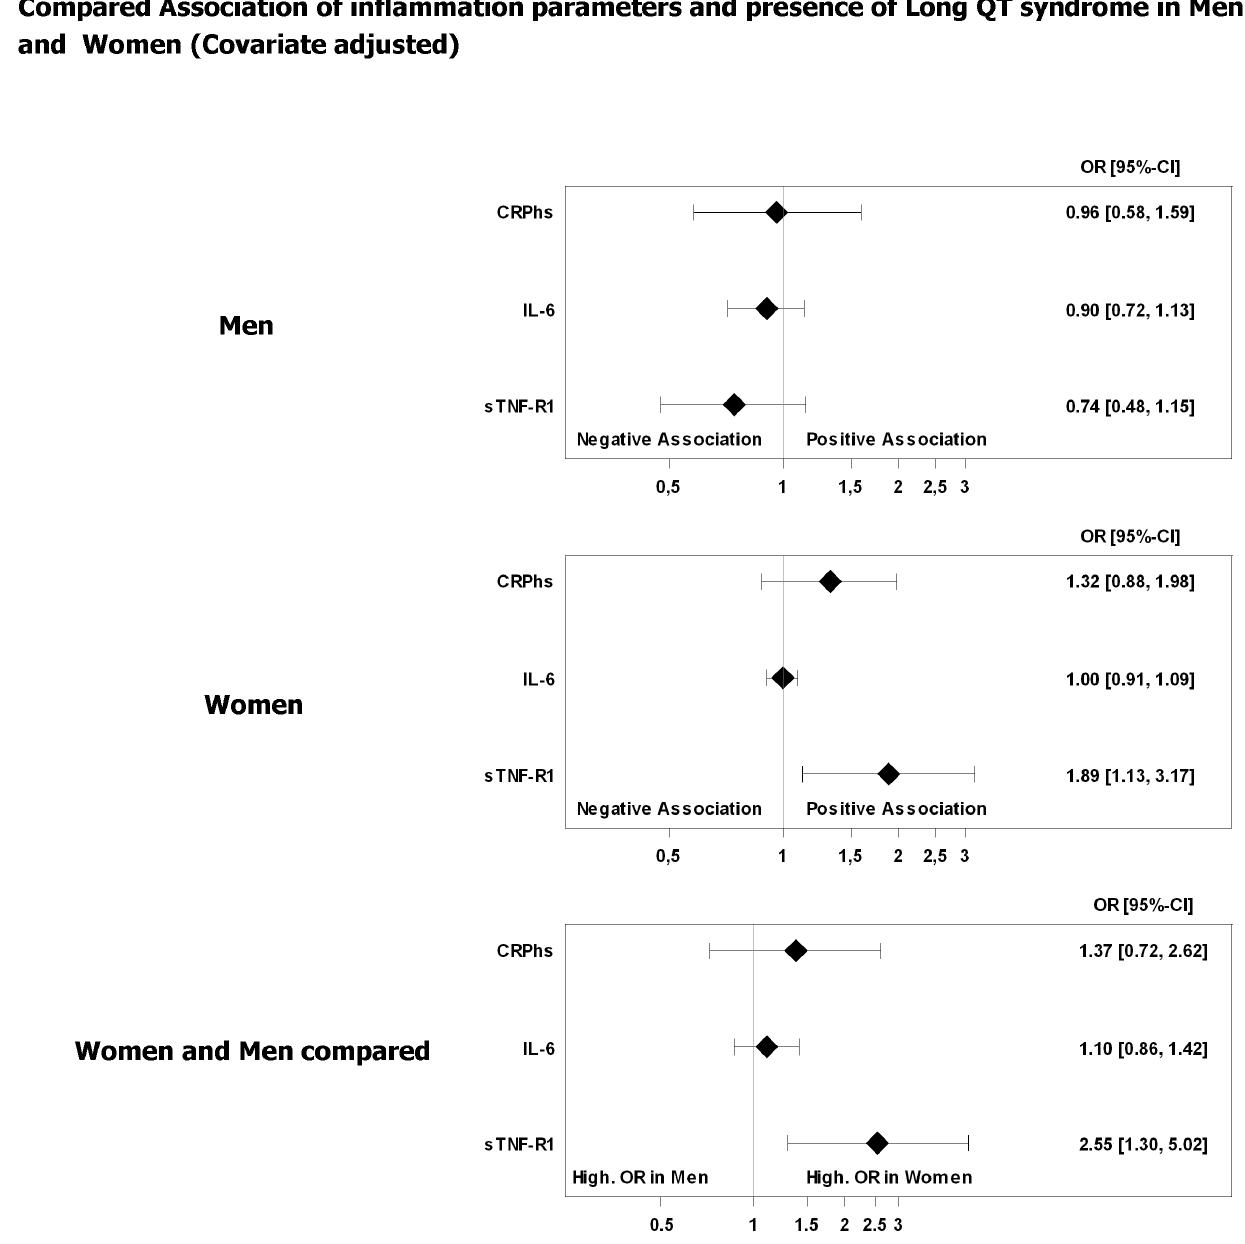
Figure 2. Association of prolonged QTc time and inflammation parameters. Odds ratios (OR) with 95% confidence interval. Models were adjusted for age, anti-arrhythmic (ATC code: C01B) and anti-phlogistic medication (ATC code: A07), current smoking status, high density lipoprotein (HDL), cholesterol, glucose blood level, alcohol intake, body mass index, thyroid stimulating hormone (TSH), systolic blood pressure and potentially QT prolonging drugs (see www.qtdrugs.org). OR refers to a 1,000 pg/mL increase in sTNF-R1, a 10 pg/mL increase in IL-6, and a 10 mg/L increase in hsCRP. doi:10.1371/journal.pone.0095994.g002 Figure 3). The estimated association of QTc and hsCRP in the multiple analysis of both sexes was only minimal with wide confidence intervals (2.17 ms/10 mg/L, 95% CI: —1.96–6.3 in men; 2.02 ms/10 mg/L, 95% CI: 2 0.23–4.27 in women). In